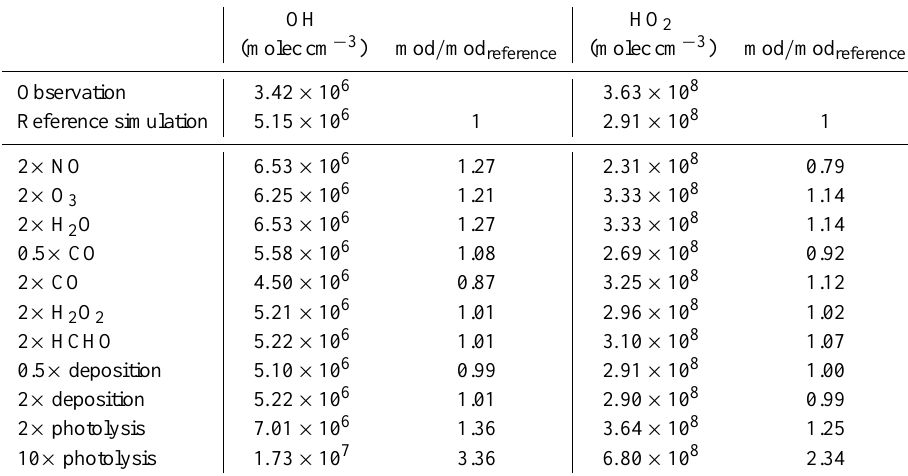
Table 5. Sensitivity analysis with respect to changes in observed, model constraining parameters. The values presented refer to a dataset around local solar noon (1p.m. in UTC + 2).